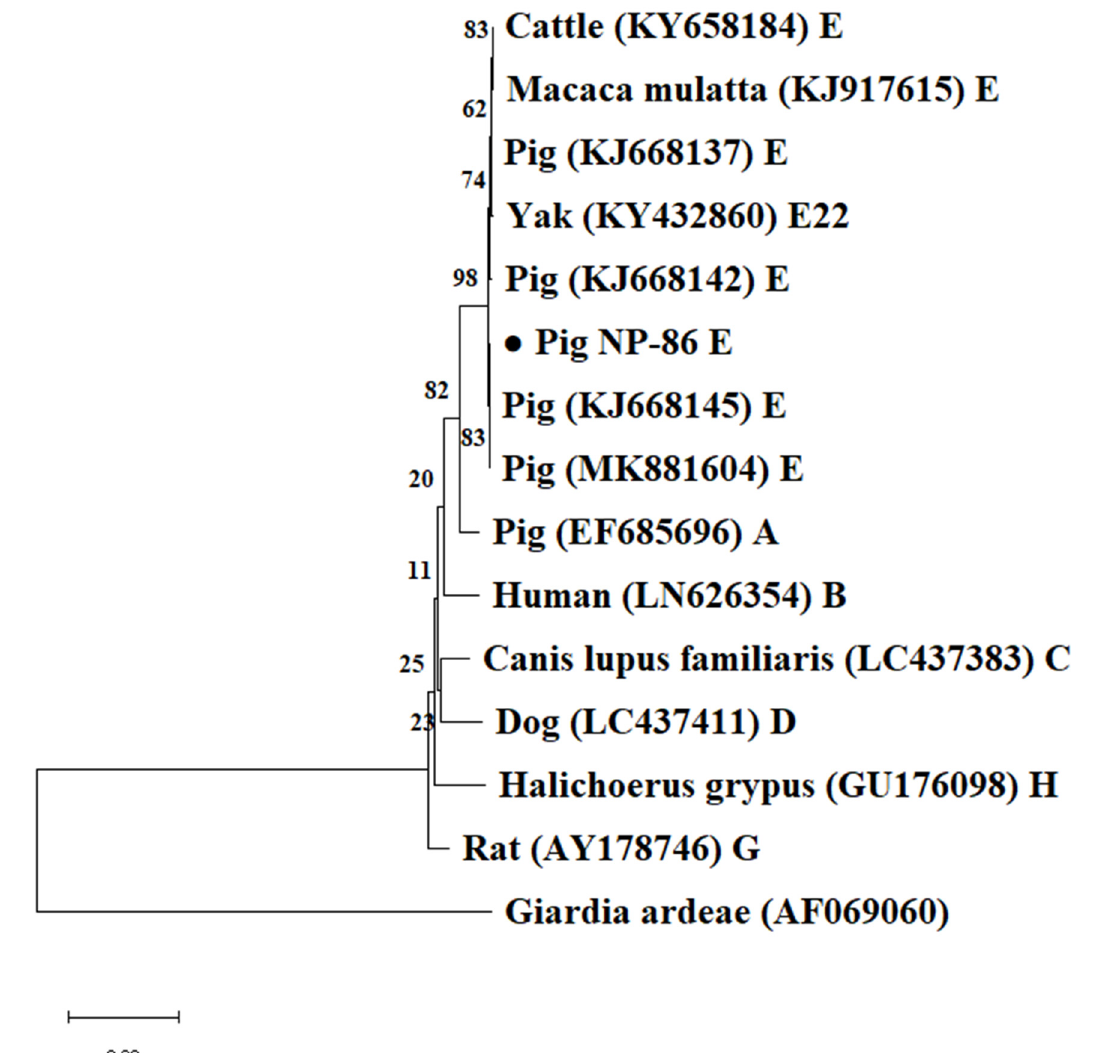
Figure 4. Phylogenetic relationships of Giardia duodenalis isolates obtained using the neighbor-joining analysis of the triose phosphate isomerase ( tpi ) nucleotide sequences. Bootstrap values >50% from 1000 replicates are shown as nodes. Giardia ardeae is used as outgroup. Filled black circles represent bg sequences generated in this study. The scale bar indicates 0.05 nucleotide substitution/site.